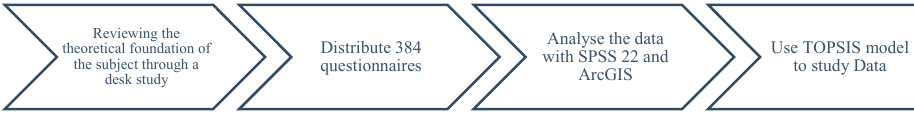
Figure 1. Workflow of the research.